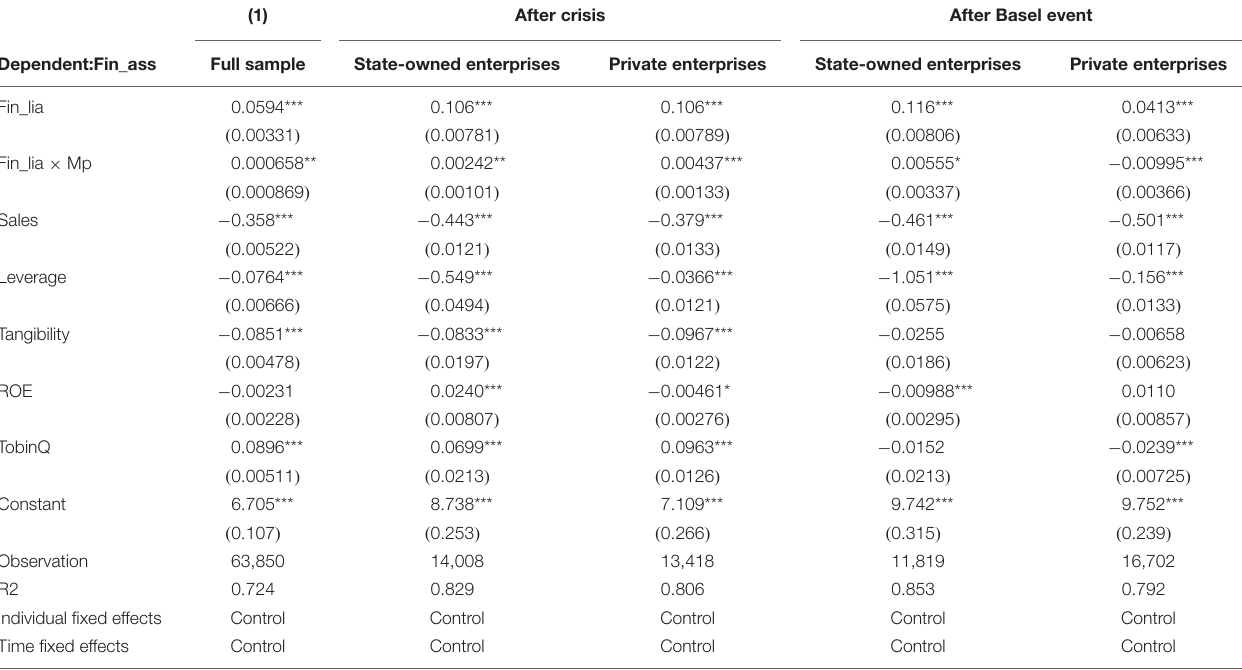
TABLE 8 | Monetary policy shocks and “Borrow to Lend” activities. (1)